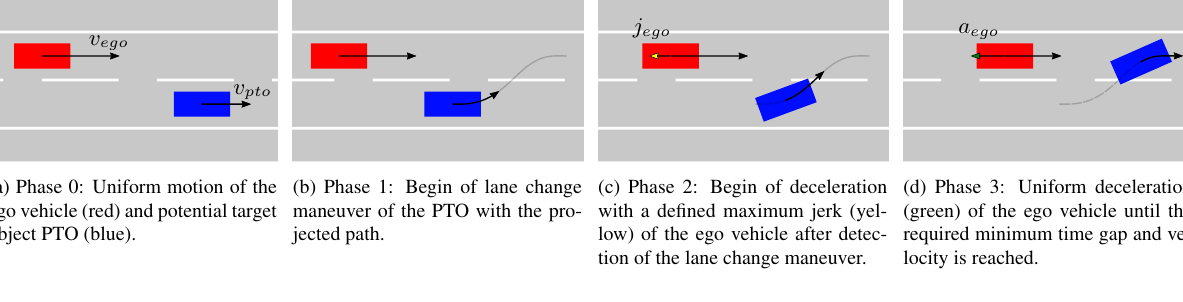
Figure 2: Typical lane change scenario of a potential target vehicle on a highway and the respective phases. Not drawn to scale.